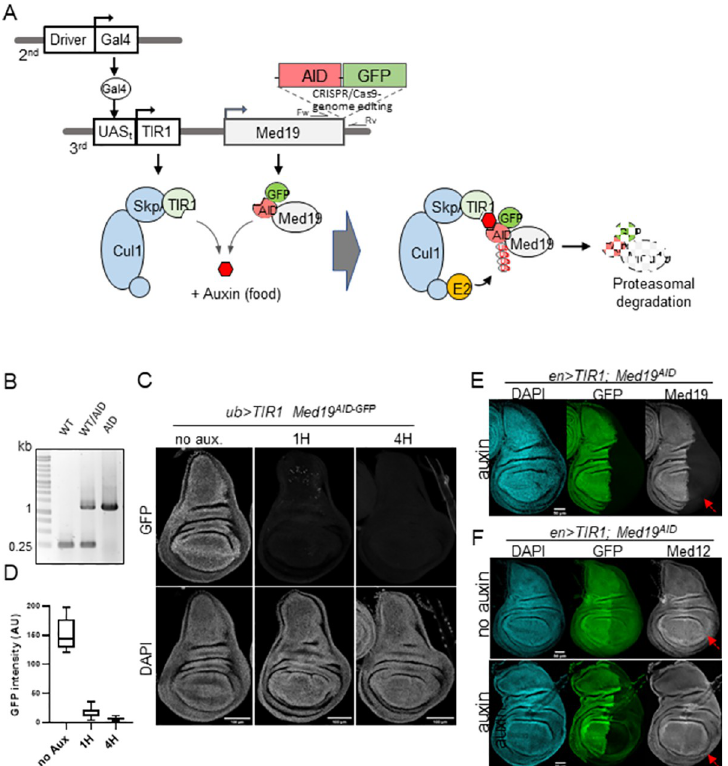
Fig 1. K-in of the Auxin Induced Degron (AID) for fast and deep depletion of Med19 in the Drosophila wing imaginal disc. (A) Principle of auxin-dependent degradation of Med19 AID in Drosophila. The Med19 endogenous gene located on the third chromosome has been engineered using CRISPR-Cas9 system in order to generate Med19 fusion protein with AID and GFP tags. The expression of the auxin-dependent and AID-specific F-box protein TIR1 is controlled by the UAS/Gal4 system. The Gal4 driver is located in the second chromosome, and the UAS-TIR1 construct in the third chromosome. The F-box TIR1 incorporates the endogenous SCF (Skip1 Cul1 F-box) E3 ubiquitin ligase complex. Auxin (added to the fly food) triggers poly-ubiquitination of Med19 AID by the SCF-TIR1 targeting the Mediator subunit to degradation by the proteasome. (B) PCR genotyping for the insertion of the AID-GFP coding sequence in the Med19 locus using the primers couple indicated in (A) with genomic DNA extracted from WT control (Med19 + left lane), Med19 + /Med19 AID heterozygous (middle lane), or Med19 AID homozygous (right lane) adult flies. WT and Med19 AID alleles theoretically produce a 270 and 1200 pb PCR product, respectively. (C) Ubiquitous Auxin-dependent degradation of Med19 AID in the wing imaginal disc. Images showing DAPI and GFP (detection of Med19 AID ) signals from ub > TIR1; Med19 AID wing discs dissected from larvae not exposed to auxin (no aux.), or fed with auxin for 1 hour (1H), or 4 hours (4H). (D) GFP signal quantification (Arbitrary Unit), as measurement of Med19 AID depletion, in ub > TIR1; Med19 AID wing imaginal discs (images shown in (C)) obtained from larvae not exposed to auxin (no Aux., n = 9), or fed with auxin during 1 hour (1H, n = 11), or 4 hours (4H, n = 12). (E) Auxin dependent degradation results in loss of both C-terminal GFP and N-terminal Med19 moieties of Med19 AID . Images showing en > TIR1 Med19 AID wing discs, in which auxin-induced degradation in the posterior compartment was performed for 4 hours, co-immunostained using anti-GFP and Med19 antibodies. (F) Auxin dependent degradation of Med19 AID does not affect Med12 expression. Wing discs from en > TIR1 Med19 AID larvae not exposed to auxin (no auxin- upper panel.), or fed with auxin (auxin -bottom panels). Co-immunostaining as in (E) except antibodies against Med12 were used.